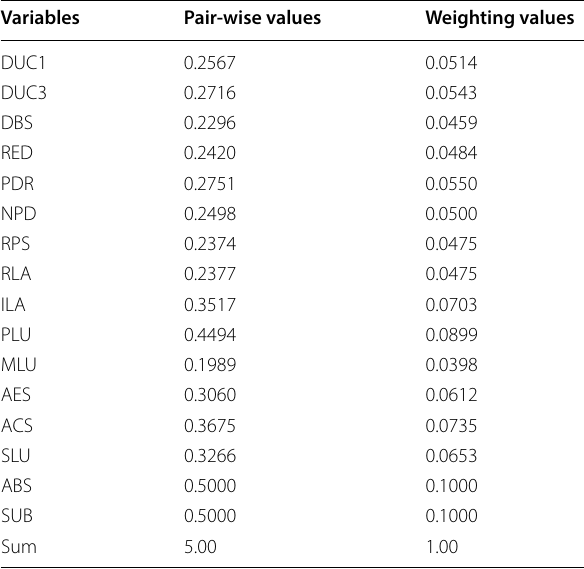
Table 3 The pair-wise values and weighting values of each variable based on F’ANP model Variables